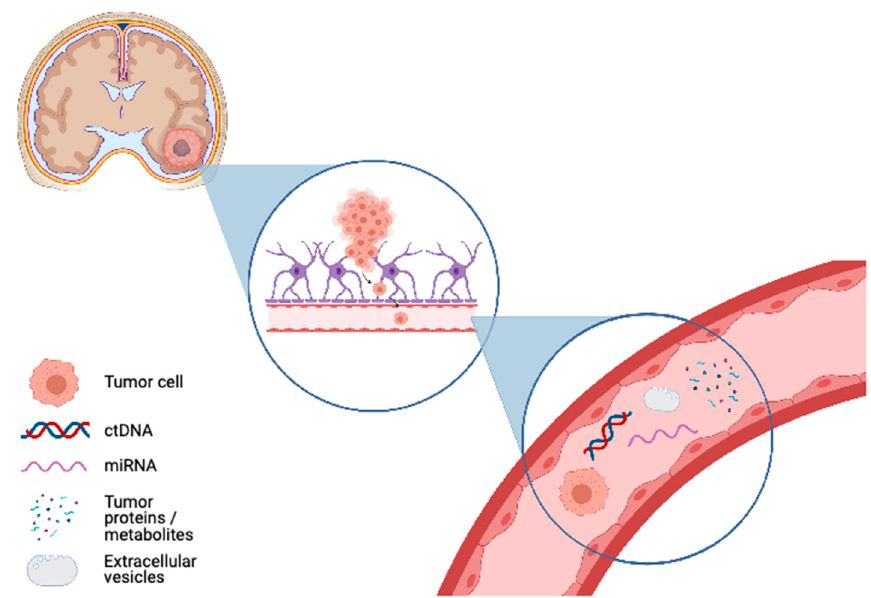
Figure 1. Liquid biopsy approaches utilized in central nervous sytem tumor diagnosis or monitoring. Upper left panel : CNS tumor of unknown diagnosis with local brain inflammation. Middle panel : Tumor analyte enters biofluid, with circulating tumor cell entering bloodstream and a representative example process is shown. Lower right panel : analytes of interest depicted in the bloodstream as representative biofluid, including circulating tumor cells, circulating tumor DNA (ctDNA), microRNAs (miRNA), proteins, metabolites and exosomes/extracellular vesicles (EVs) (created with BioRender.com, accessed on 14 February 2021).